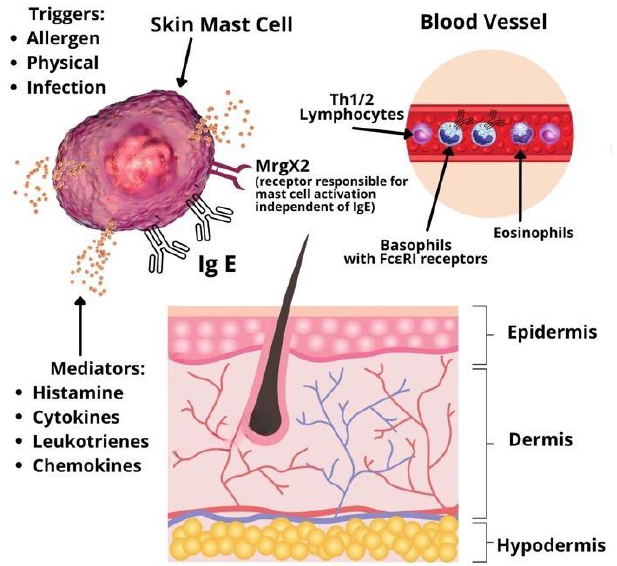
Figure 1. Pathophysiology of chronic spontaneous urticaria.